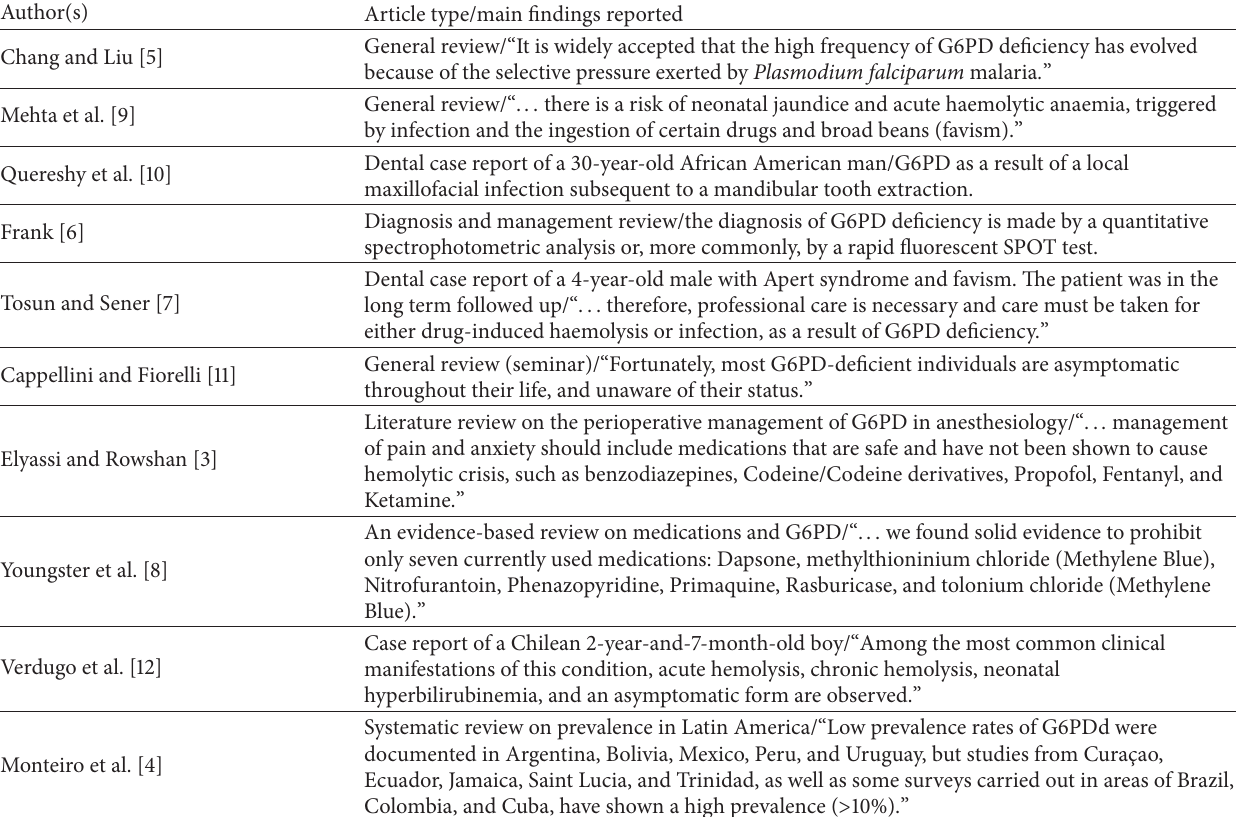
Table 1: Full-text article finally retrieved and